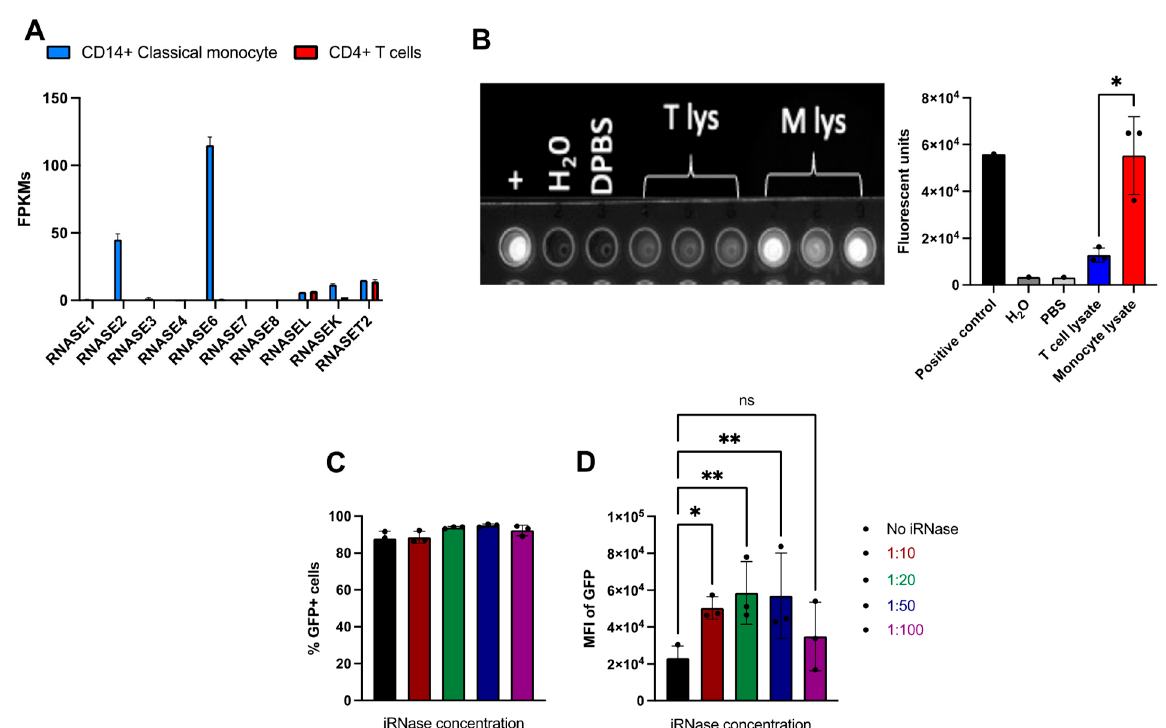
Figure 3. RNase expression profiles in monocytes and T cells, and RNase inhibitor (iRNase) enhanced MFIs of GFP in monocytes. ( A ) mRNA expression profiles of RNases in monocytes and T cells from BLUEPRINT project (ebi.ac.uk). ( B ) Top view picture of the RNase assay depicts qualitative measurement (left panel) and bar graph depicts quantitative measurement (right panel) of RNase activity in T-cell lysate (T lys), monocyte lysate (M lys). ( C ) Bar graph showed % GFP-positive cells, and ( D ) MFI of GFP+ cells 24 h after electroporation of GFP mRNA along with iRNase at the indicated concentrations. Statistical analyses were performed using two-way ANOVA followed by Dunnett’s T3 multiple comparison test (n = 3 independent biological donors) (ns = p > 0.05, * p < 0.05, ** p < 0.01).